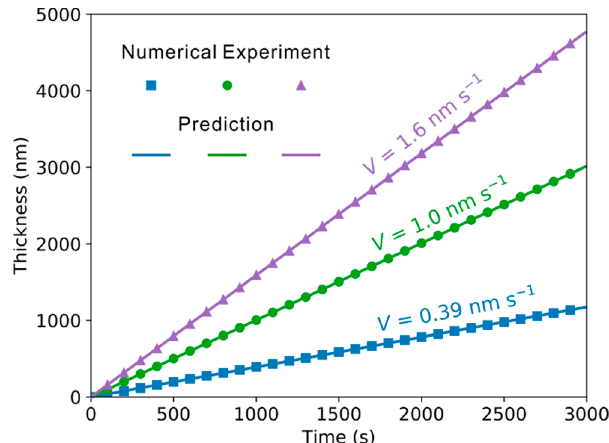
Figure 3. Comparison between the temporal thickness of thin films deposited with the deposition rates of 0.39, 1.0, and 1.6 nm s − 1 due to the phase-field simulations and the corresponding results predicted by the deposition rate. Symbols denote the phase-field simulated results, while solid lines denote the predicted results based on the pre-set deposition rates.